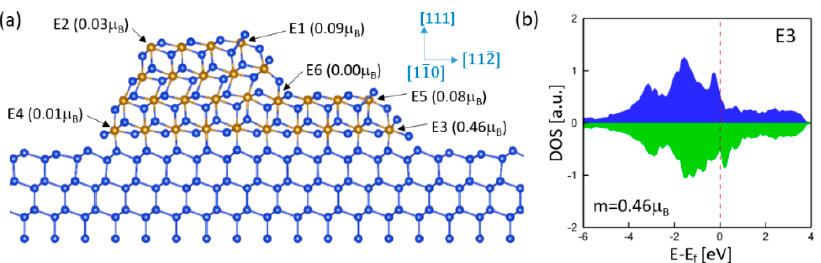
Figure 6. ( a ) Atomic structure and spin moments of γ -FeSi 2 /Si(111) epitaxial nanoislands with a step at the (001) facet. The edges are oriented along the [11(cid:3364)0] direction. ( b ) DOS of the Fe atom at edge E3.